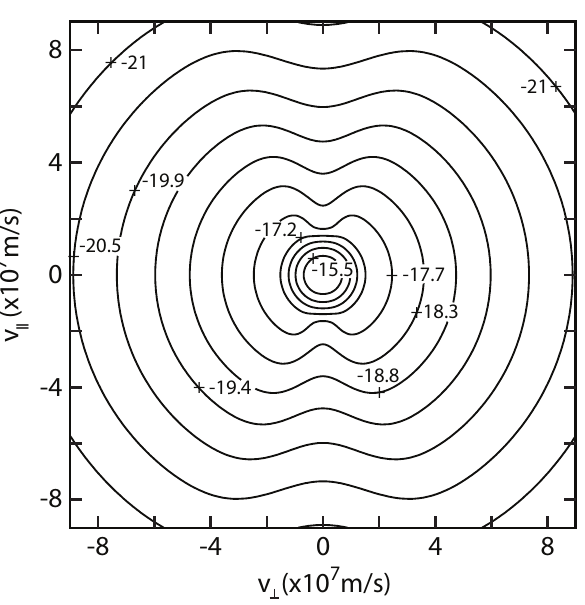
Fig. 5. Contours of PSD determined from the analytical model de- scribed by Eq. (1) with parameters from the